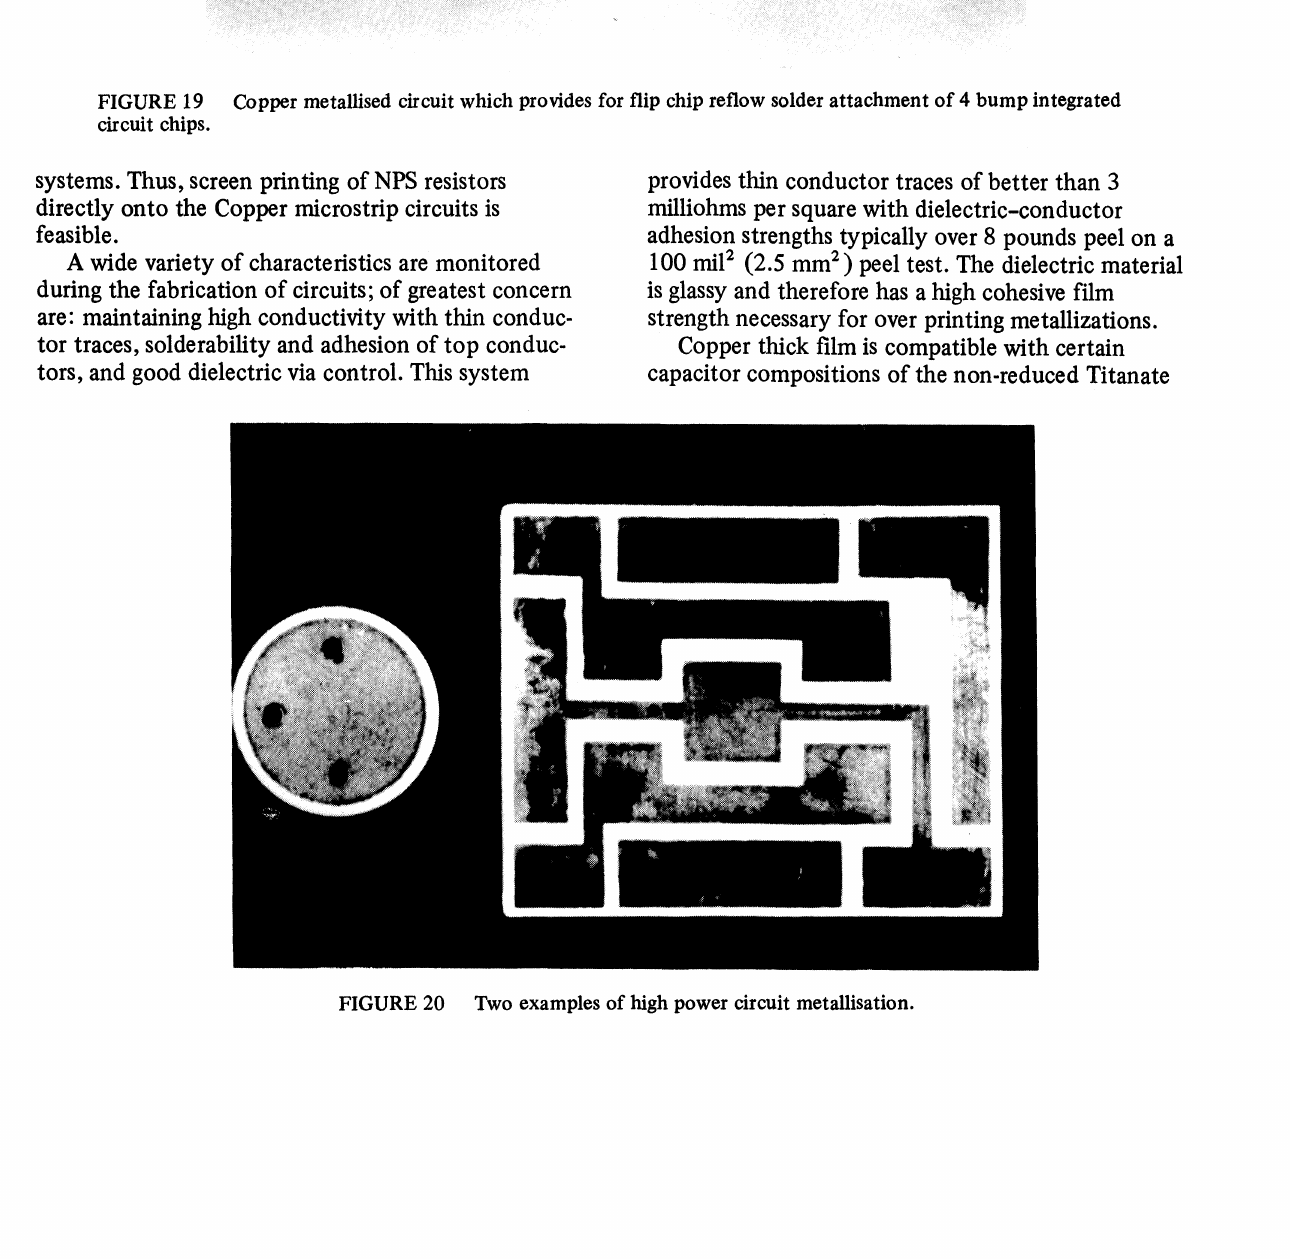
FIGURE 20 Two examples of high power circuit